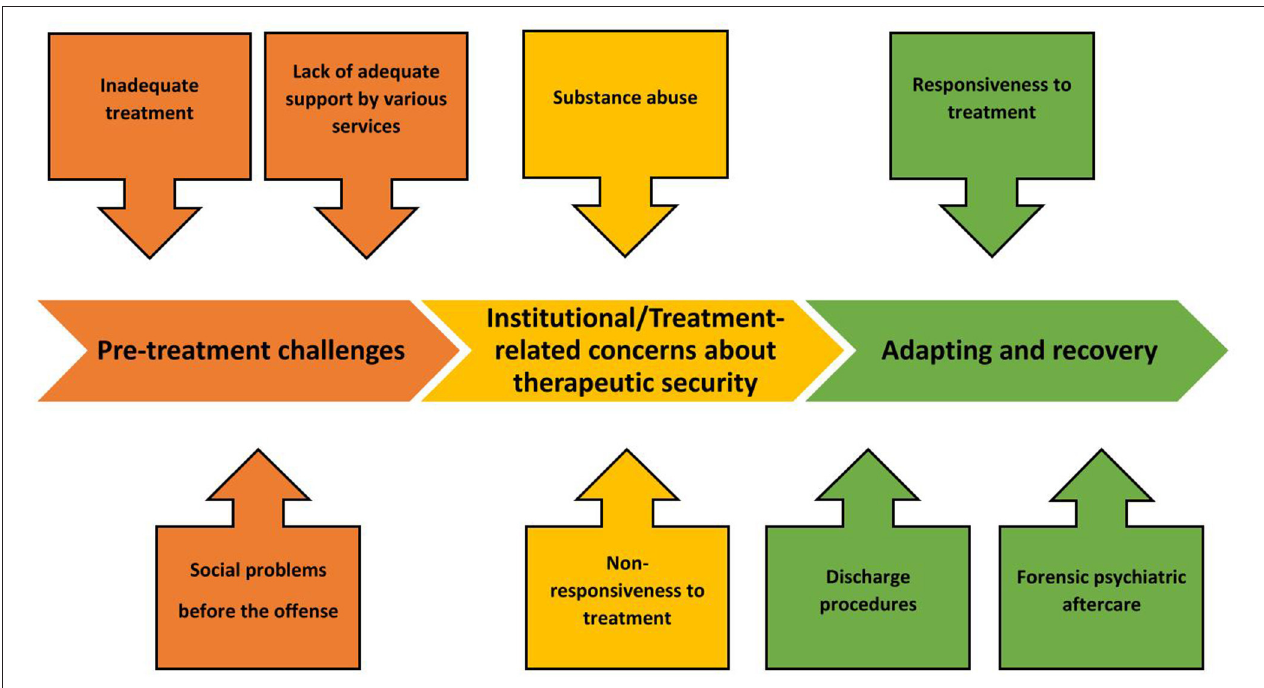
FIGURE 1 | Factors affecting treatment regress and progress along the forensic rehabilitation process. The main themes are (1) pre-treatment challenges, (2) institutional/treatment-related concerns about therapeutic security and (3) adapting and recovery. For each main theme, (1–3) subthemes emerged, as